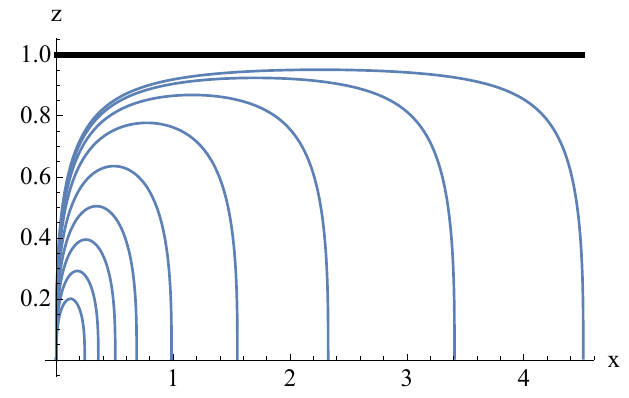
Figure 9 . Each blue curve is z ( x ) with di(cid:11)erent widths, and the black horizontal line is the horizon of AdS-RN black hole. Apparently the curve approaches the horizon as w